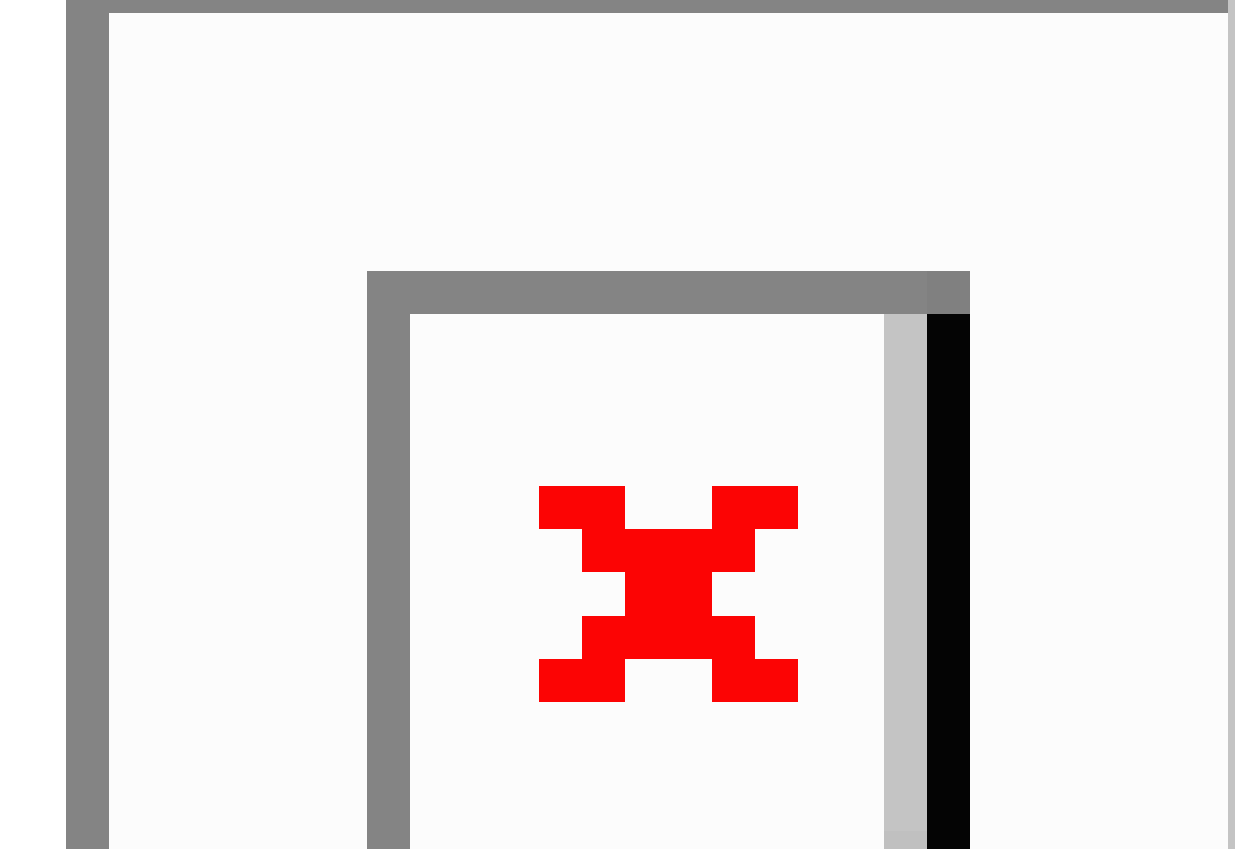
Figure 1. SmartLink participant flow diagram. SMS: short message